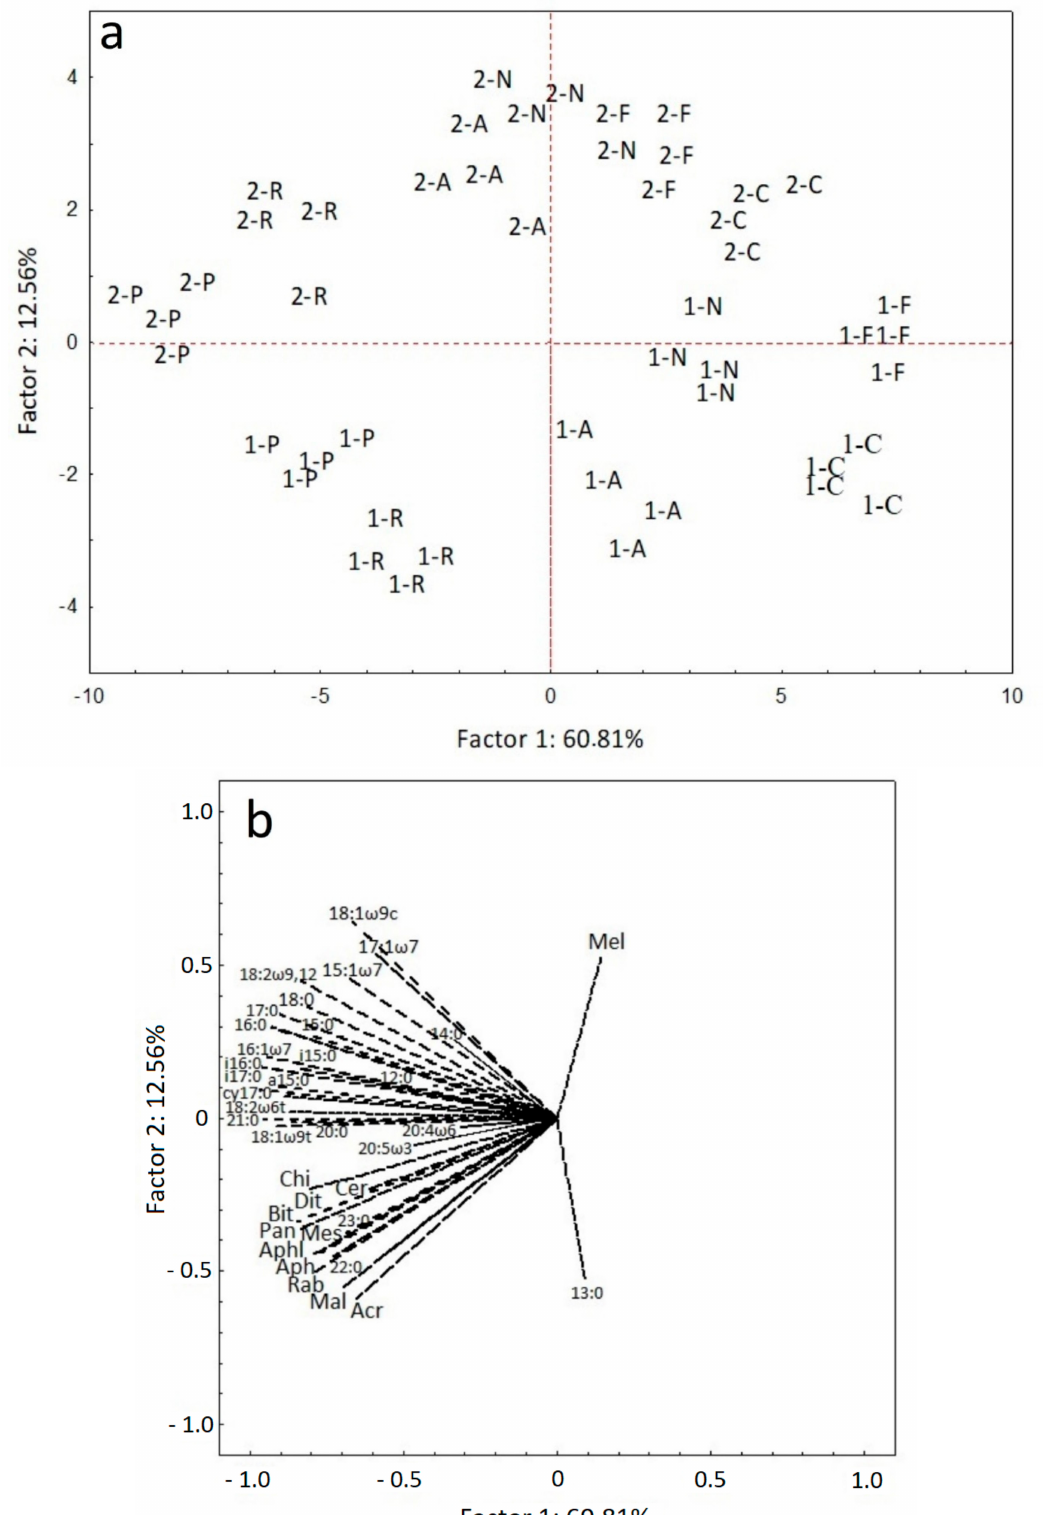
Figure 3. ( a ) Ordination of soil samples based on ( b ) PLFA biomarkers and nematode genera on a PCA biplot. In ( a ), the first symbol indicates the assessment time (1: 15DAA, 2: 45DAA) and the second symbol indicates the treatment (C: control, F: fluopyram, N: Nemagold, P: P. crispum , R: E. sativa , A: P. anisum ). For all cases n =